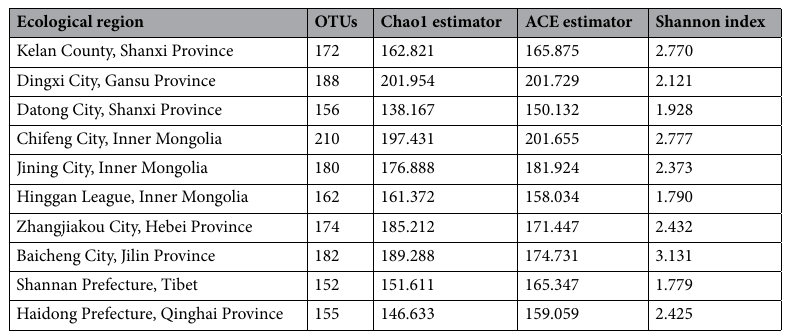
Table 2. Diversity indices of fungal pathogens on grains of Bayou 13 from 10 ecological regions.